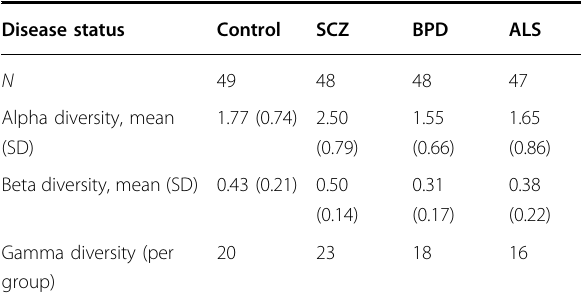
Table 2 Microbial diversity measures Disease